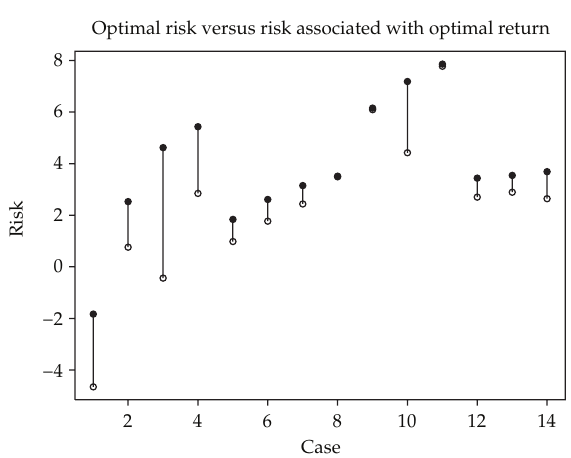
Figure 4: Optimal risk M ∗ versus the risk value M associated with the optimal return for all